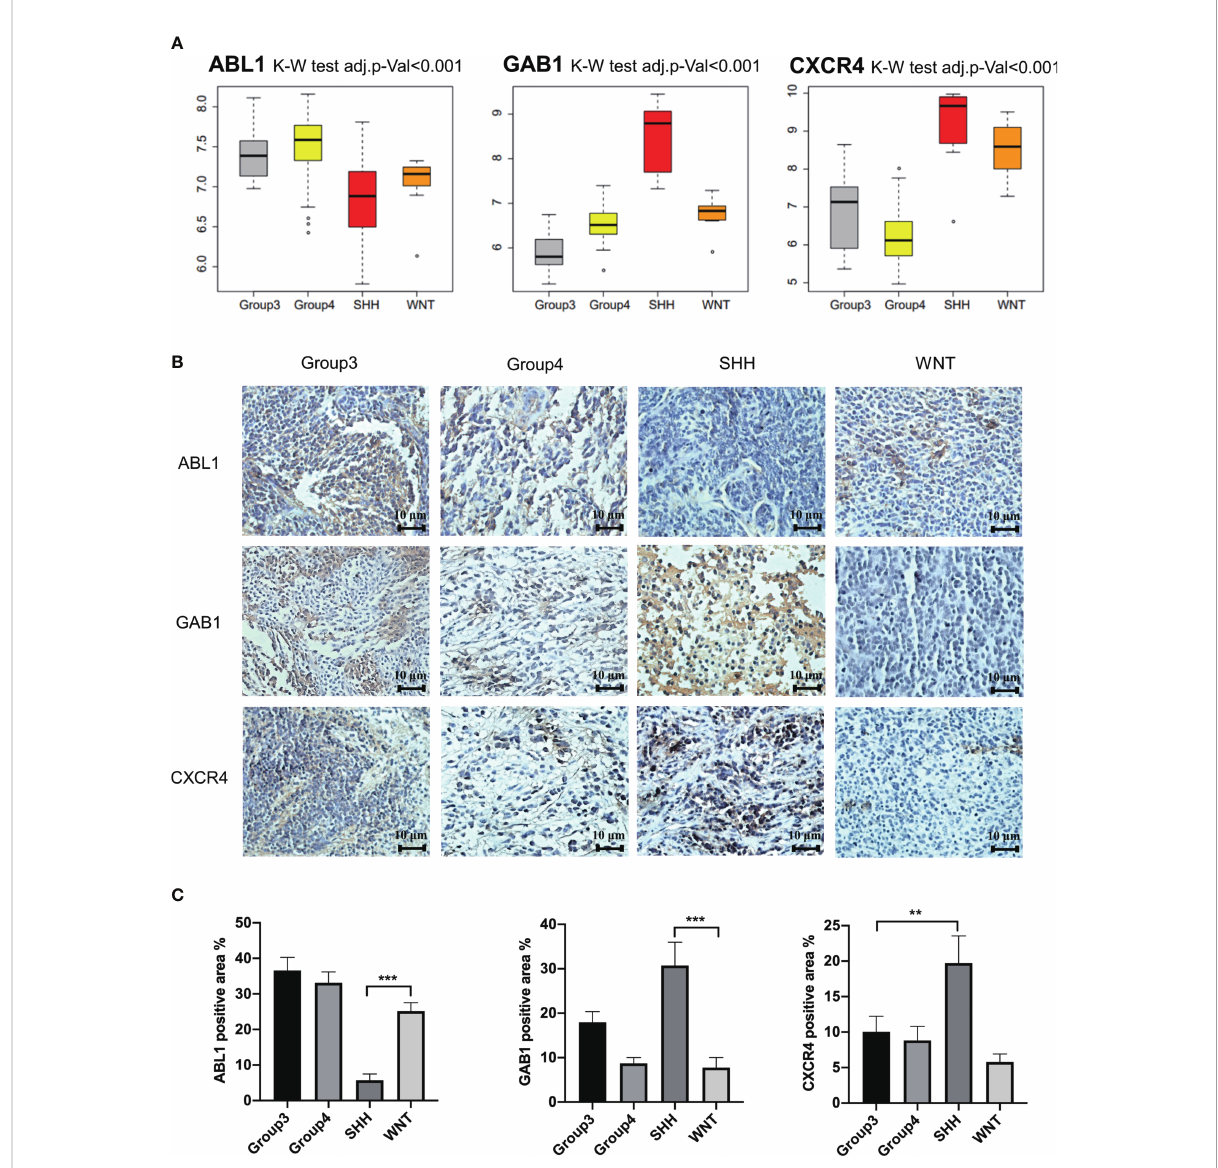
FIGURE 6 Further veri fi cation of hub genes. (A) The expression of GAB1, ABL1, and CXCR4 in different subtypes from the independent data set. (B) Further veri fi cation by immunohistochemistry (n = 5) (** p ≤ 0.01, *** p ≤ 0.001). (C) Average positively stained area percentage of ABL1, GAB1, and